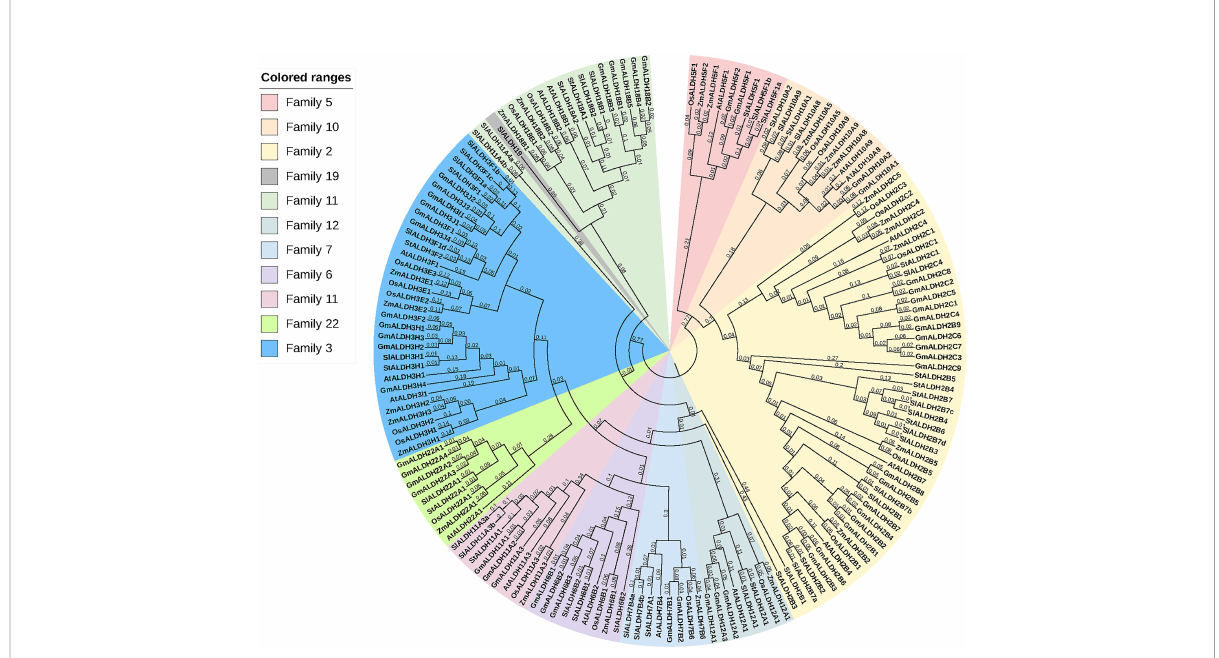
FIGURE 4 Phylogenetic analysis of ALDH superfamily proteins from various plant species. The subfamilies are highlighted in different colors. At; A. thaliana, Os; O. sativa, St; S. tuberosum, Sl; S. lycopersicum, Zm; Z. mays, Gm; G. max . The tree was constructed using the neighbor-joining method with 1000 bootstrap replications in MEGA